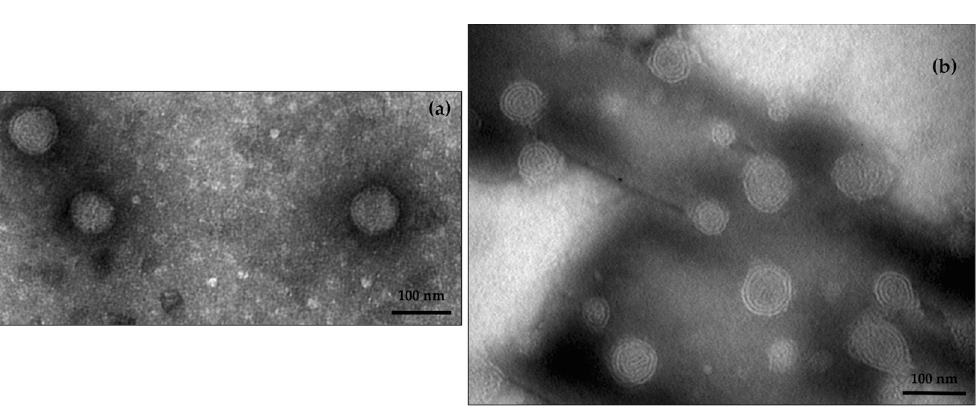
Figure 1. TEM images of LPs-AG ( a ) and CLPs-AG ( b ) (scale 100 nm).